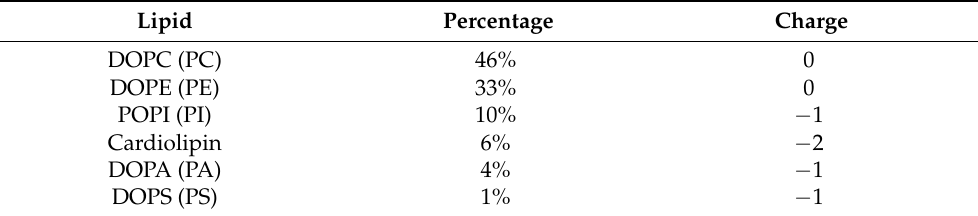
Table 1. Composition and charge of the lipids in the membrane, obtained from